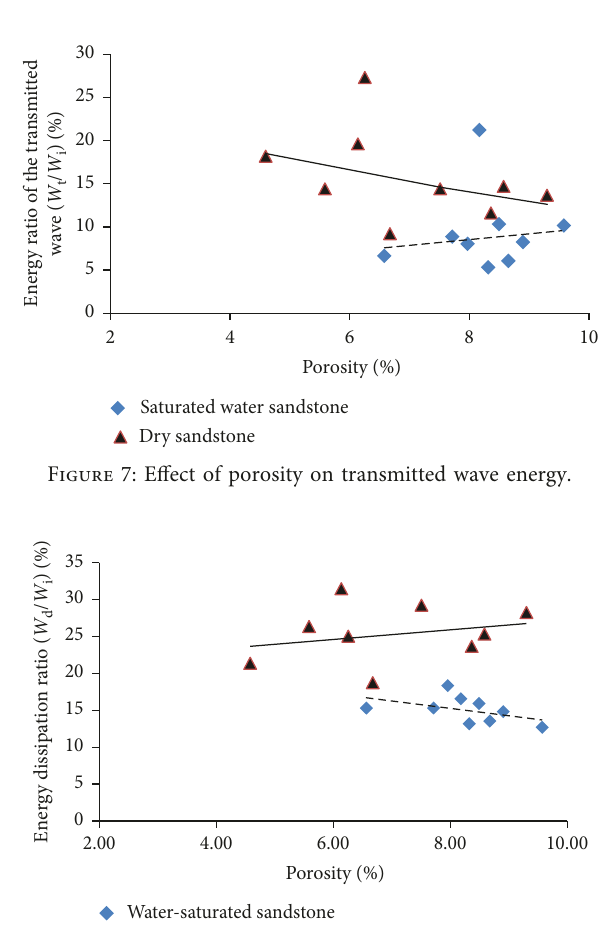
sandstoneWater-saturated Dry